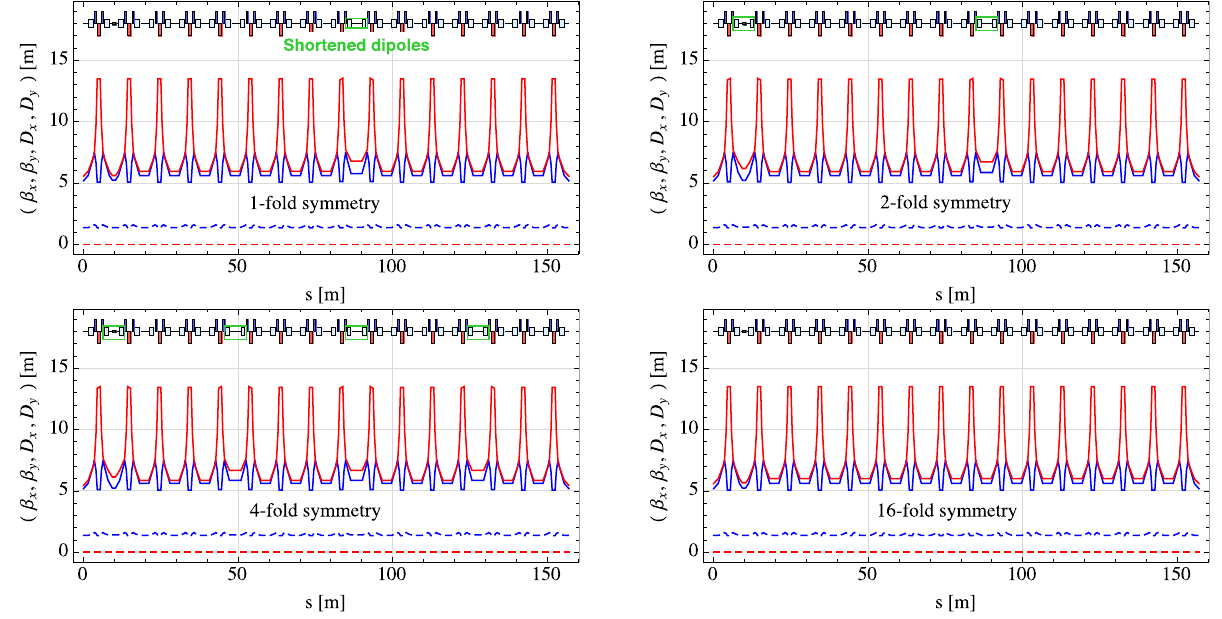
symmetry.FIG. 8. Optics of the 16-cell triplet lattice with onefold, twofold, fourfold and complete 16-fold symmetry. The symmetry is broken by shortening the bends in the corresponding number of cells indicated in green.